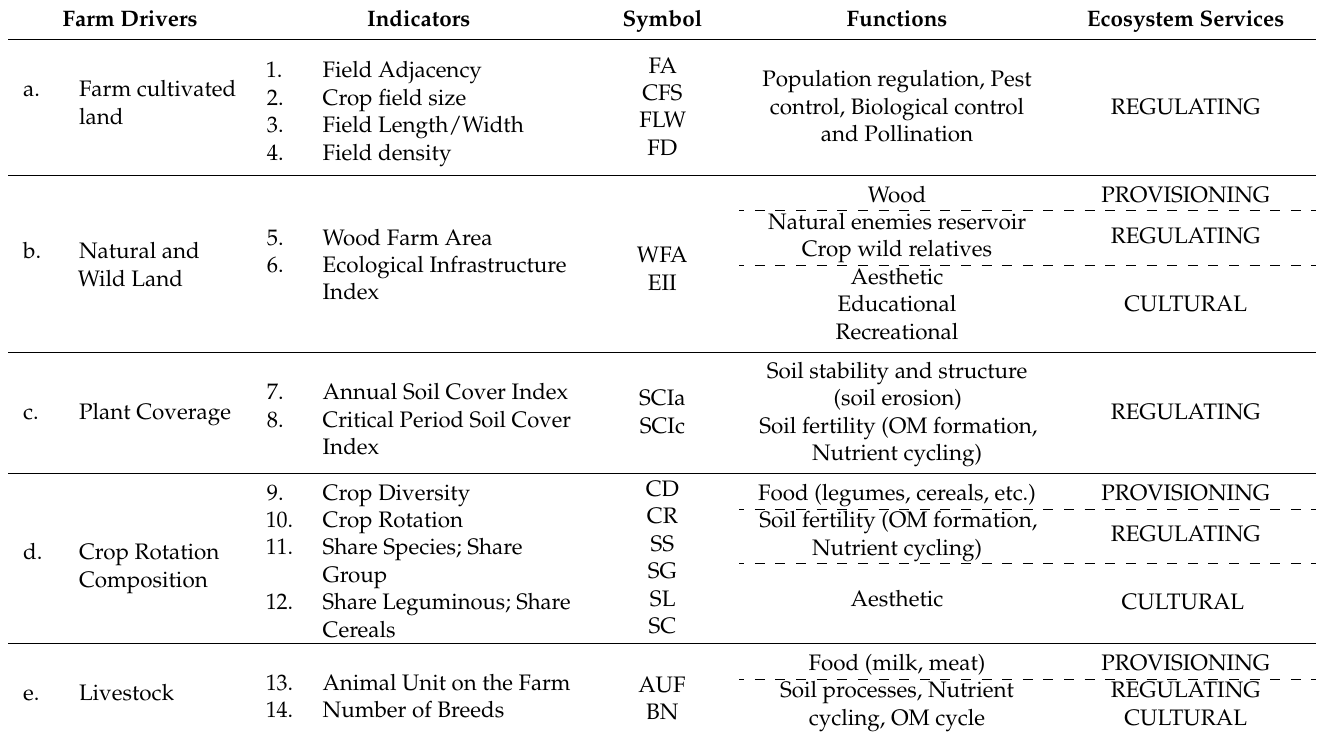
Table 1. Planned biodiversity: drivers, indicators, ecosystem services and